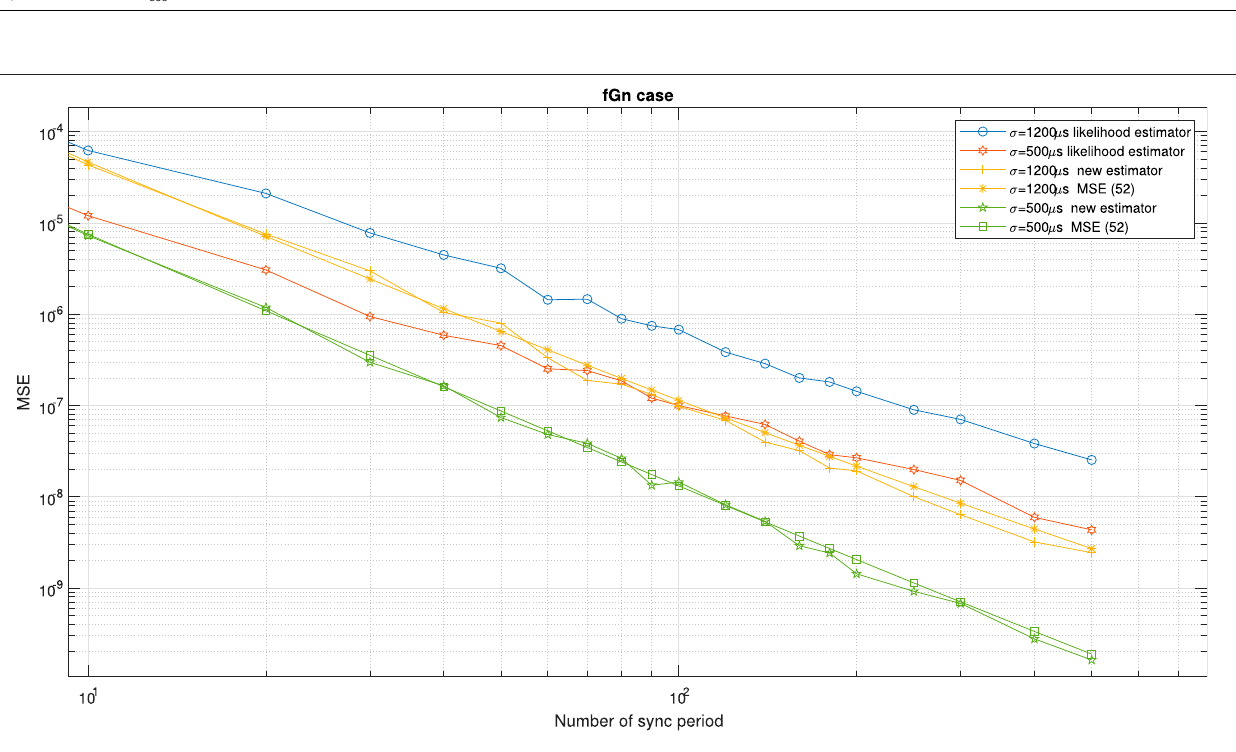
FIGURE 8 | Performance comparison between the new clock skew estimator Eq. 3 with the clock skew estimator of Noh et al. [34] denoted here as the likelihood estimator. In addition, we have the simulated performance results for our new proposed expression for the MSE Eq. 52 for the fGn case. α (cid:1) 50 ppm , Q (cid:1) 5 ms , ) , σ ω (cid:1) σ ω (cid:1) σ , d (cid:1) 5 ms , d (cid:1) 5.5 ms , H (cid:1) 0.6. The results were obtained for 100 Monte-Carlo trails. T syn (cid:1) 15 . 6 ms ( 64 packet ms sm sec 1 2